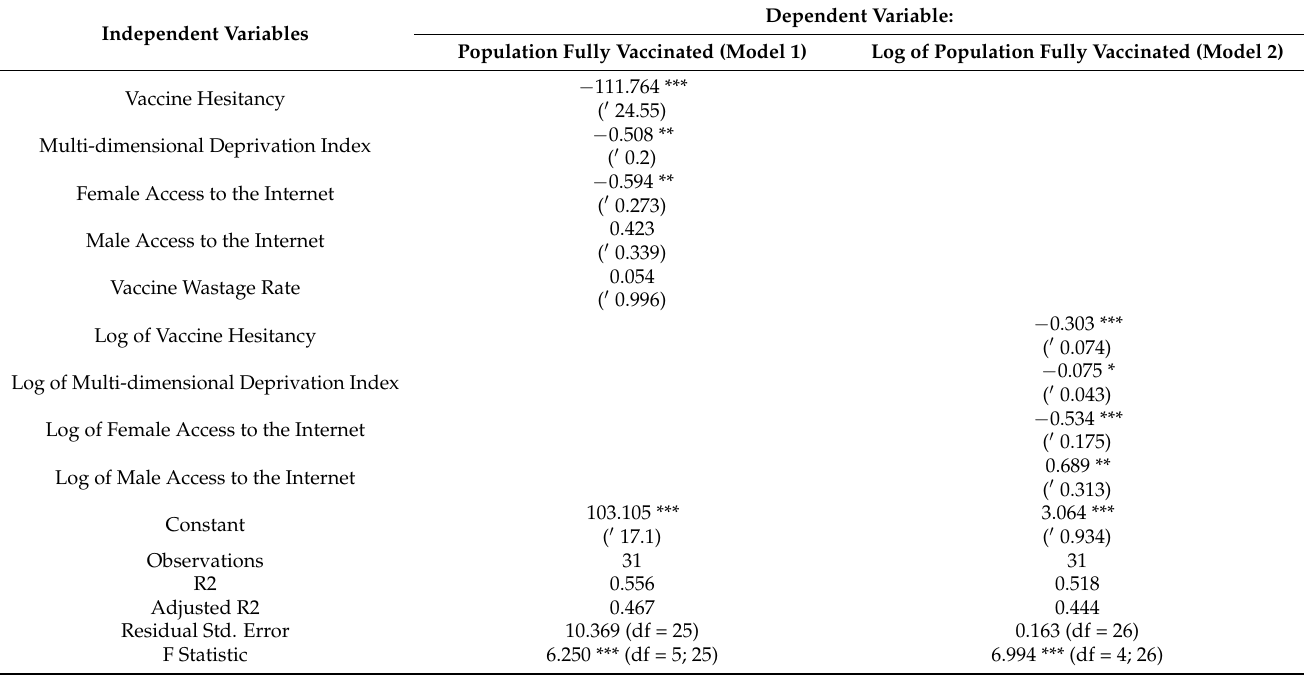
Table 1. Multiple linear regression